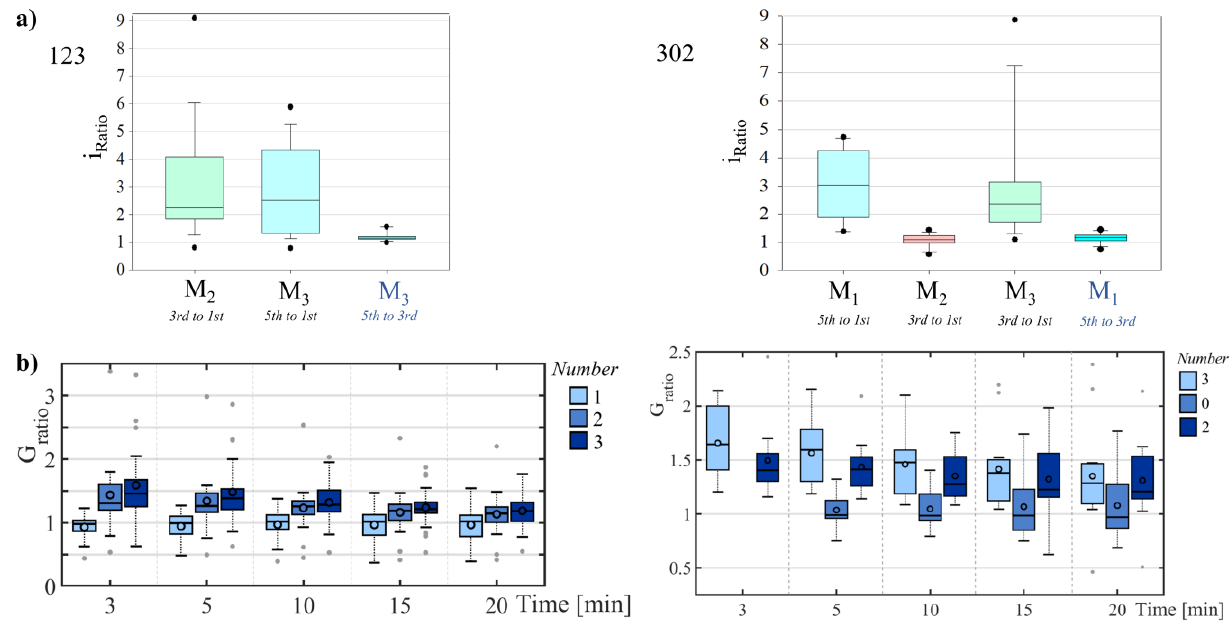
Fig. 4: Boxplots based on all measurements with number 123 (left, N=19) and number 302 (right, N=13). a) Boxplots of i Ratio . In case of number 123, no DC voltage pulses were applied to M 1 , three positive pulses were applied to M 2 and 5 to M 3 . In case of number 302, 5 positive DC pulses were applied to M 1 , 3 negative pulses were applied to M 2 and 3 positive pulses were applied to M 3 . b) Boxplots of G ratio over time for the three different M electrodes. States 1, 2, and 3 (left plot, N=19) were stored in the skin under the electrodes M 1 , M 2 , and M 3 respectively. Friedman test and pairwise comparison (Tukey test) show that there are significant differences between state 2 and state 1 and also between states 3 and 1 but not between states 2 and 3 at all time points (see also table 2 in the supplemental information). States 3, 0, and 2 (right plot, N=13) were stored in the skin under the electrodes M 1 , M 2 , and M 3 respectively. Similar as for number 123, Friedman test and pairwise comparison (Tukey test) show that there are significant differences between state 2 and state 0 and also between states 3 and 0 but not between states 2 and 3 at all time points. There is no data for M 2 (state 0) at minute 3 since 190 seconds of positive DC voltage pulses followed before the small signal conductance was conducted (see Fig.